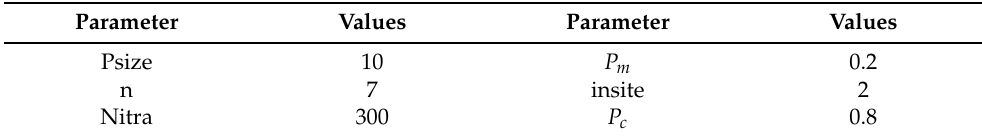
Table 5. GA parameters specifications.